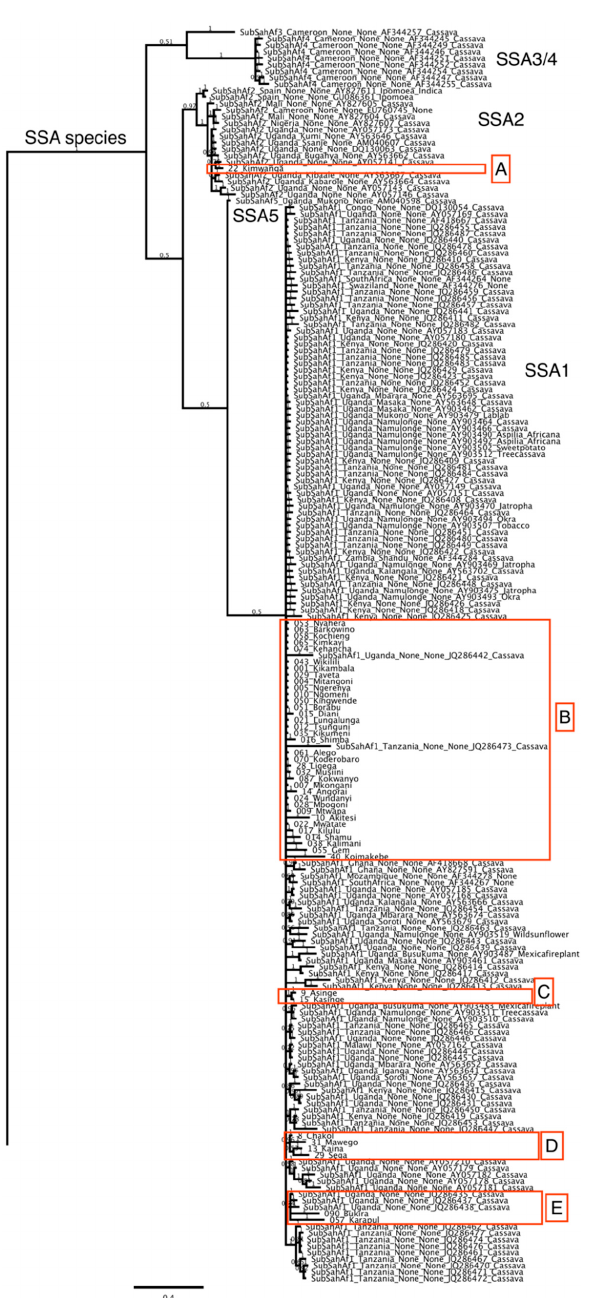
Figure 3. Entire MrBayes phylogenetic tree based on the mitochondrial cytochrome oxidase I sequence for B. tabaci collected in Kenya. Figure A1. (a–c) Distinct clades A–E blown up below with new sequences generated in this study highlighted in green.